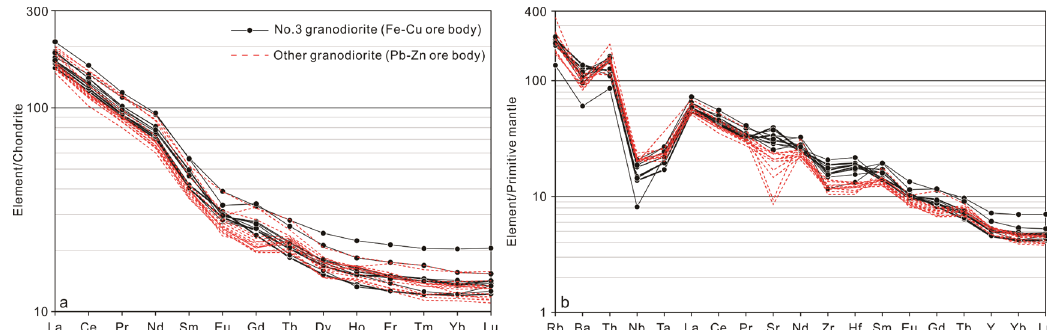
Figure 8. Chondrite-normalized REE ( a ) and primitive mantle normalized trace element ( b ) diagrams for rocks of the No. 3 granodiorite and other granodiorites in the Shuikoushan deposit. Data of other granodiorite are from [30], chondrite and primitive mantle values are from [52].